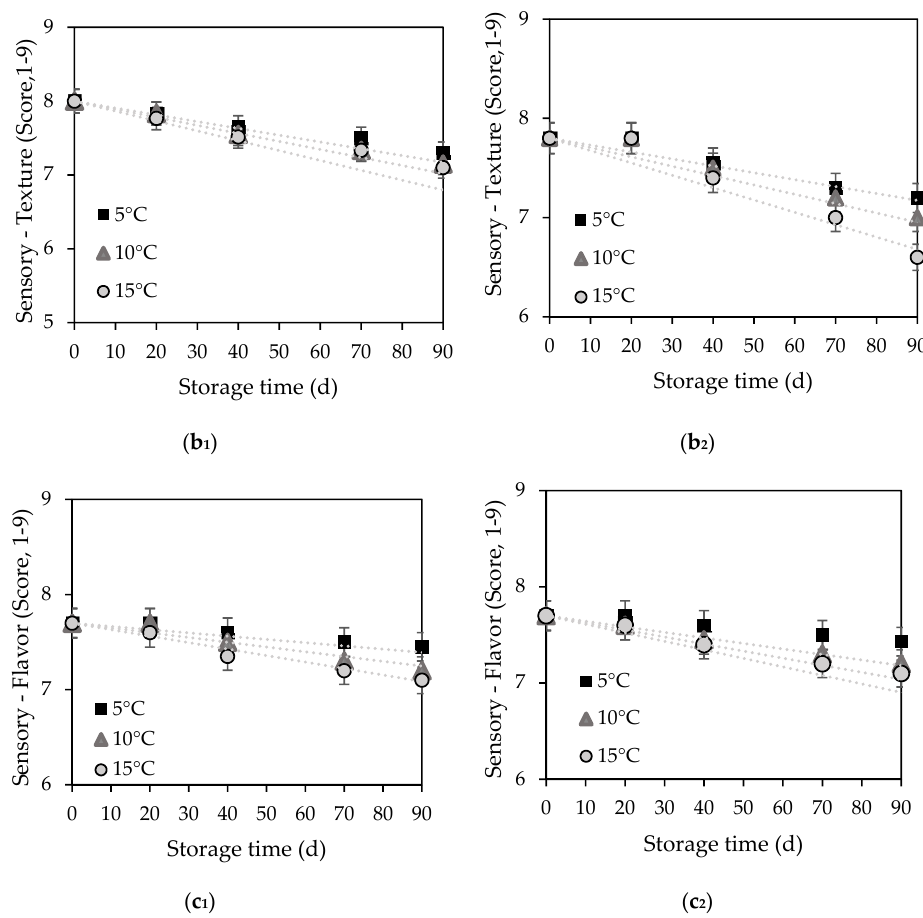
Figure 4. Scores for ( a ) color, ( b ) texture, and ( c ) flavor (scale 1–9) of pumpkin cuts (in solution of SY Whey or water) (Index 1: OD SY Whey and Index 2: OD Water ). Experimental points correspond to isothermal temperature conditions ( ) 5 °C, ( ) 10 °C, ( ) 15; lines represent the respective model fit.